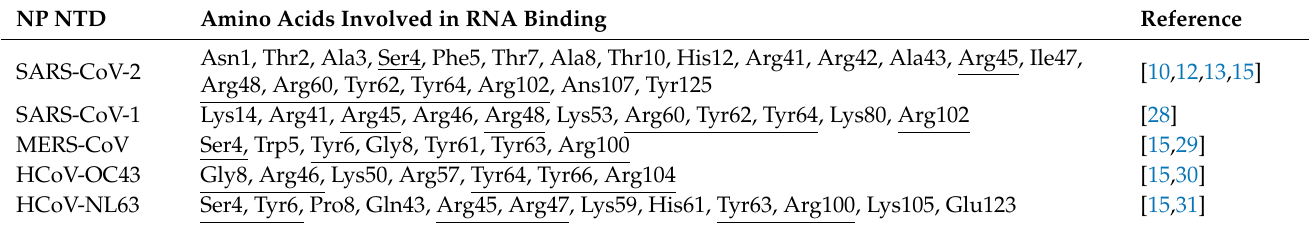
Table 1. Amino acids involved in RNA binding of the NP NTD of different coronaviruses (SARS- CoV-2, SARS-CoV-1, MERS-CoV, HCoV-OC43, and HCoV-NL63). The sequence data were taken from UniProt.kb. Residues that occurred in more than one NTD are underlined.